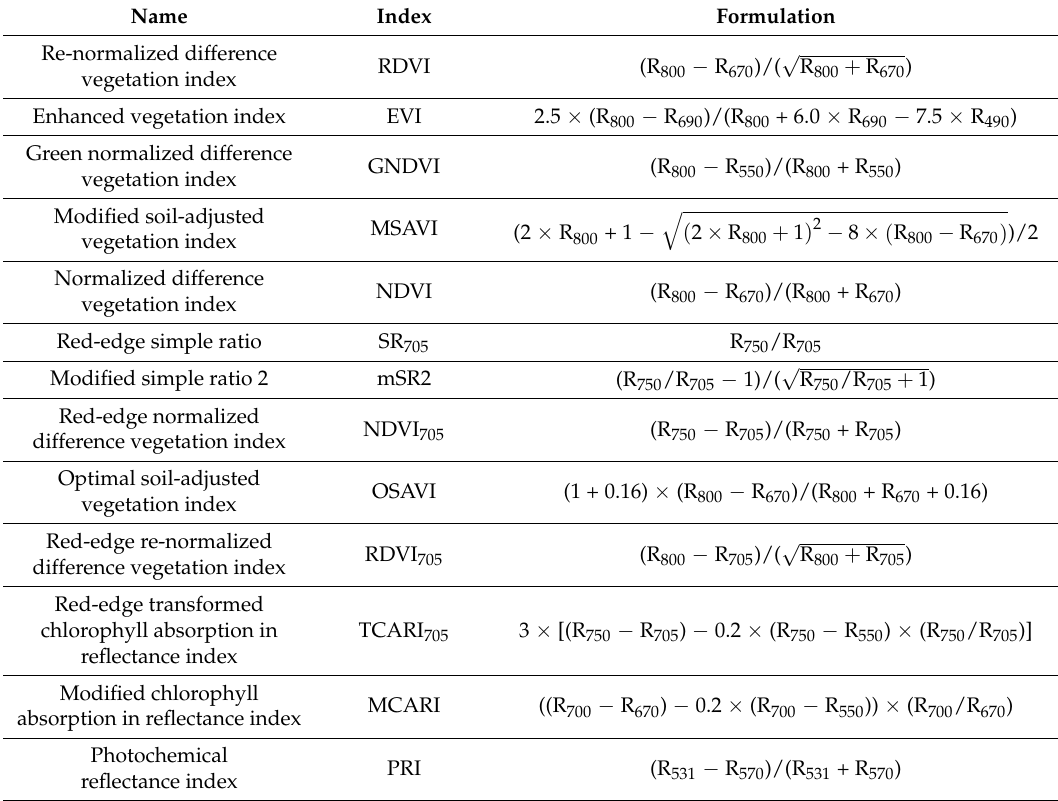
Table 1. Definitions of the vegetation indices (VIs) evaluated in this